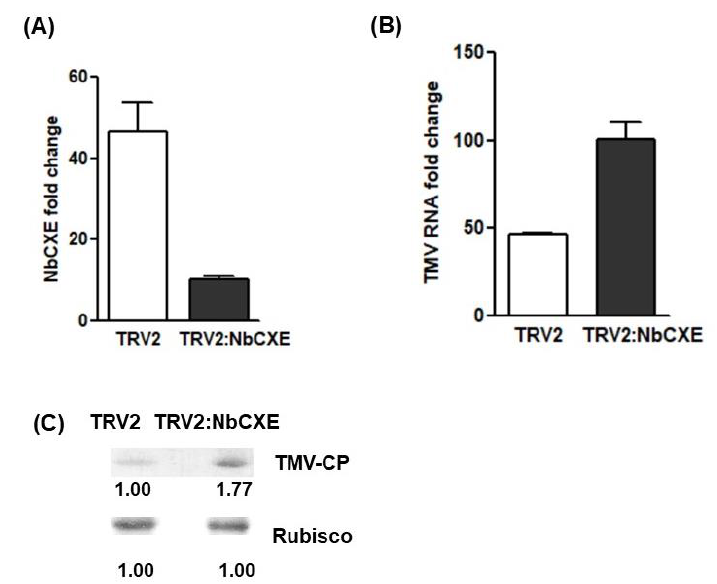
Figure 3. ( A ) The transcriptional level of NbCXE was down-regulated about 40 fold in the NbCXE- silencing plants, as compared to that of control plants. ( B ) Higher TMV RNA accumulation was detected in the NbCXE silencing plants than in the control plants. ( C ) Higher TMV CP was detected in the NbCXE silencing plants, as compared with that of control plants.